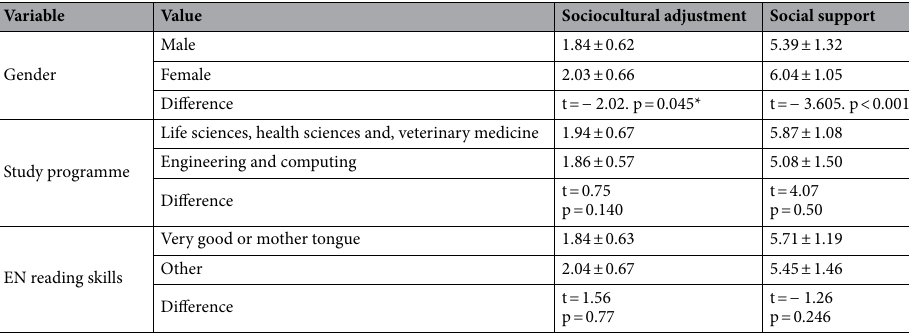
Table 4. Sociocultural adjustment and social support by gender and studying-related factors. *p <